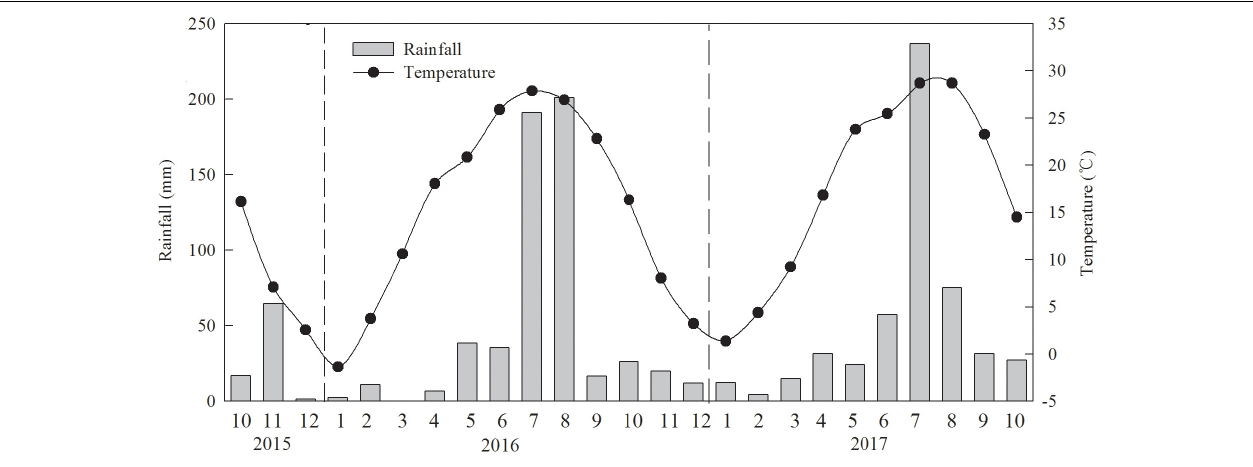
FIGURE 1 | Monthly total rainfall and monthly mean temperature during the crop growing season in the experiment conducted during 2015–2017.